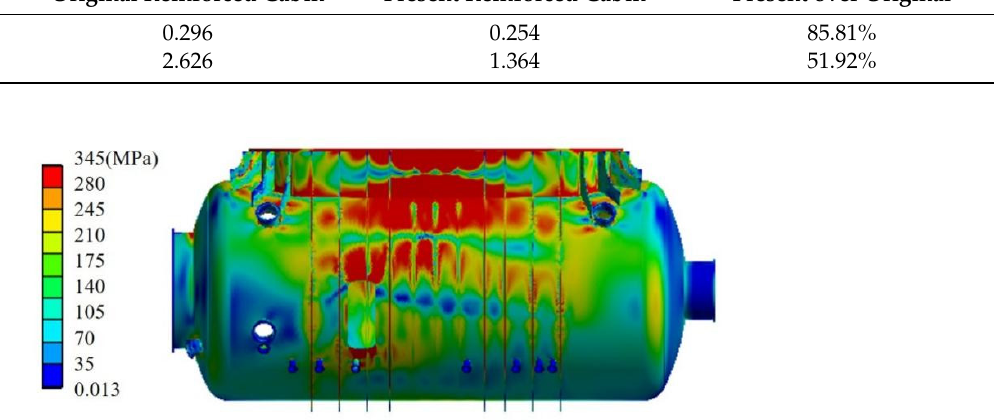
Figure 11. Contours of the von Mises stress distribution of the test cabin under the limit load after the circumferential ribs are applied.